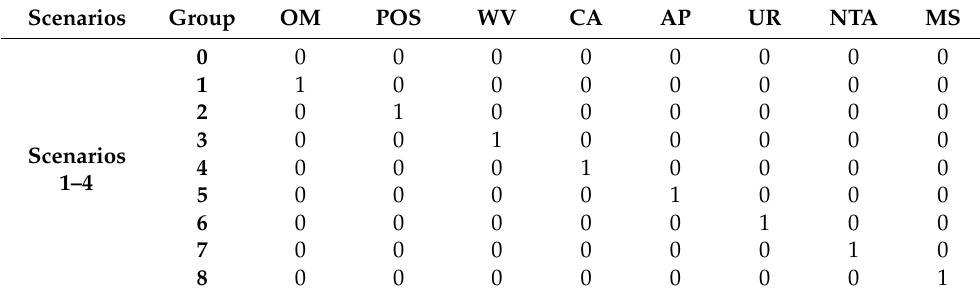
Table 1. Experimental table of external environmental conditions to improve the combined biodegrad- ability of thermophilic bacteria of FQ derivatives in sewage sludge composting